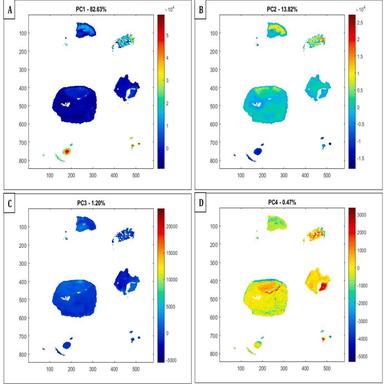
PCA model of the NMI obtained after melting process, displaying the composite image of PC1, PC2, PC3 and PC4 surfaces (A-D), with the corresponding explained variance. Same explanation for color gradient from.